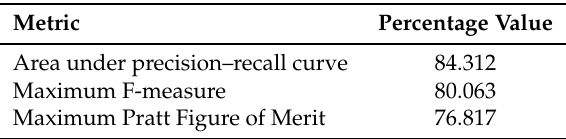
Table 5. Area under mean precision–recall curve, maximum mean F-measures, and maximum mean Pratt Figure of Merit for the remote sensing images mosaics. The values are expressed as percentage values.